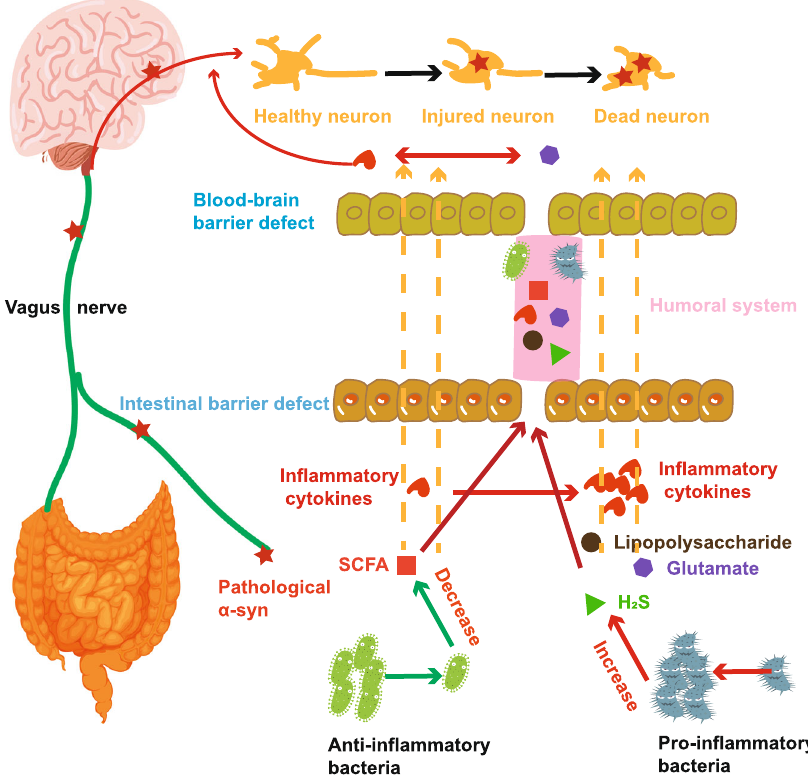
Fig. 7 The potential pathogenesis of Parkinson ’ s disease based on in fl ammation. Changes in bacterial abundance may lead to decreased anti-in fl ammatory substances, such as short-chain fatty acids (SCFAs), and increased pro-in fl ammatory substances (Lipopolysaccharide, Glutamate, H 2 S), resulting in the accumulation of pathological α -synuclein ( α -syn), increased in fl ammatory cytokines, intestinal in fl ammation and intestinal barrier defects. These substances may reach the brain through the vagus nerve or humoral system, and may eventually cause Parkinson ’ s disease